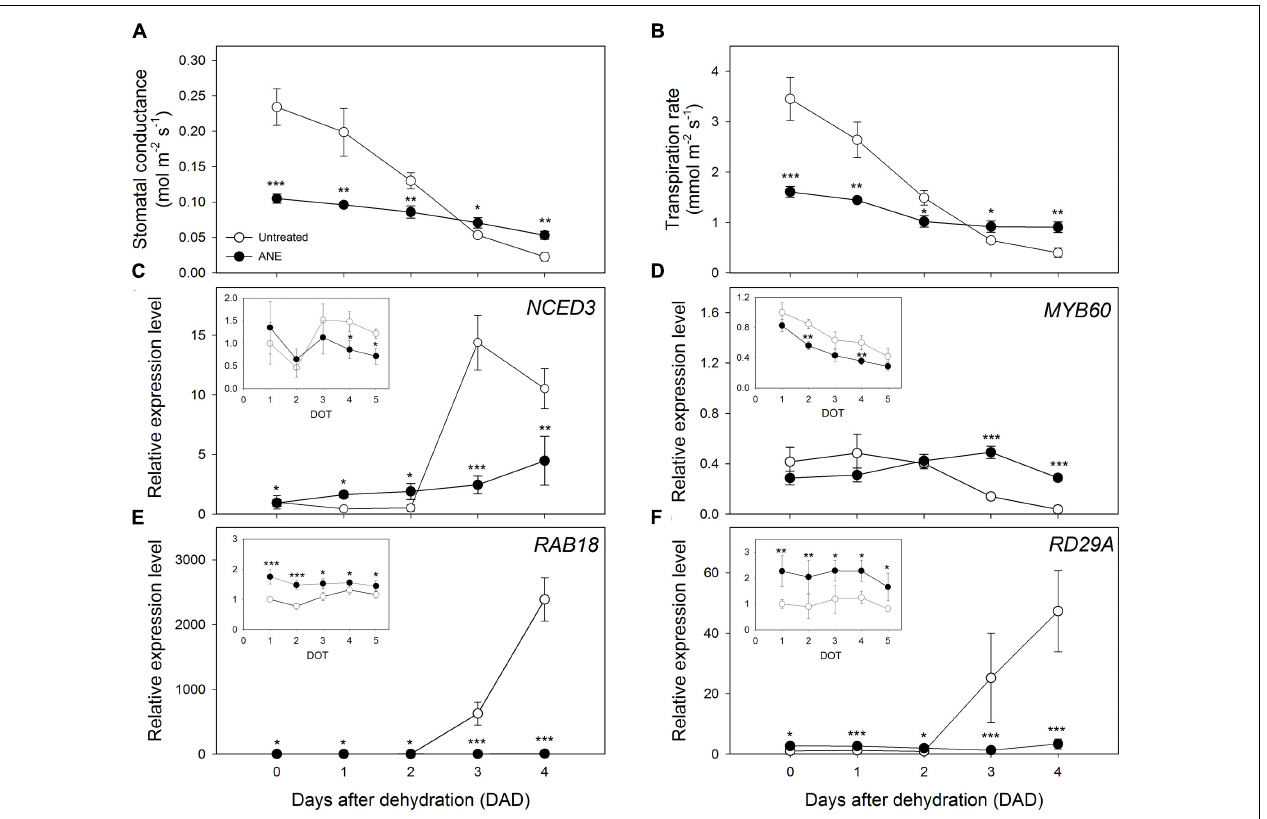
FIGURE 2 | Modulation of stomatal closure and water efflux in association with ABA synthesis and responsive gene expression analysis, during 4 days of dehydration. Time 0 is the dehydration stress starting time and it corresponds exactly with the last day of Ascophyllum nodosum extract (ANE) treatment. Measurement of stomatal conductance (A) and transpiration rate (B) , during 4 days after dehydration (0–4 DAD). Each dot shows the mean ± SE of nine biological replicates. Analysis with qPCR of genes expression during 5 days of treatment (1–5 DOT, inset) and 4 days after dehydration (0–4 DAD) for NCED3 (C) MYB60 (D) RAB18 (E) and RD29A (F) . Each dot shows the mean ± SE of four biological replicates. Untreated (white dot) and ANE treated (black dot) samples were analyzed by one-way ANOVA ( P < 0.05), ∗ P ≤ 0.05; ∗∗ P ≤ 0.01; ∗∗∗ P ≤